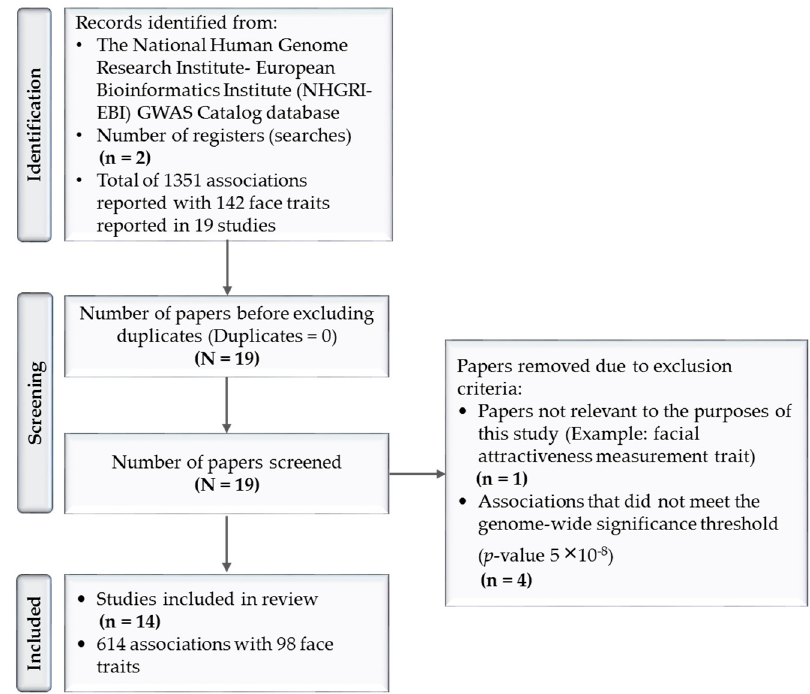
Figure 1. Literature review stages using PRISMA approach.